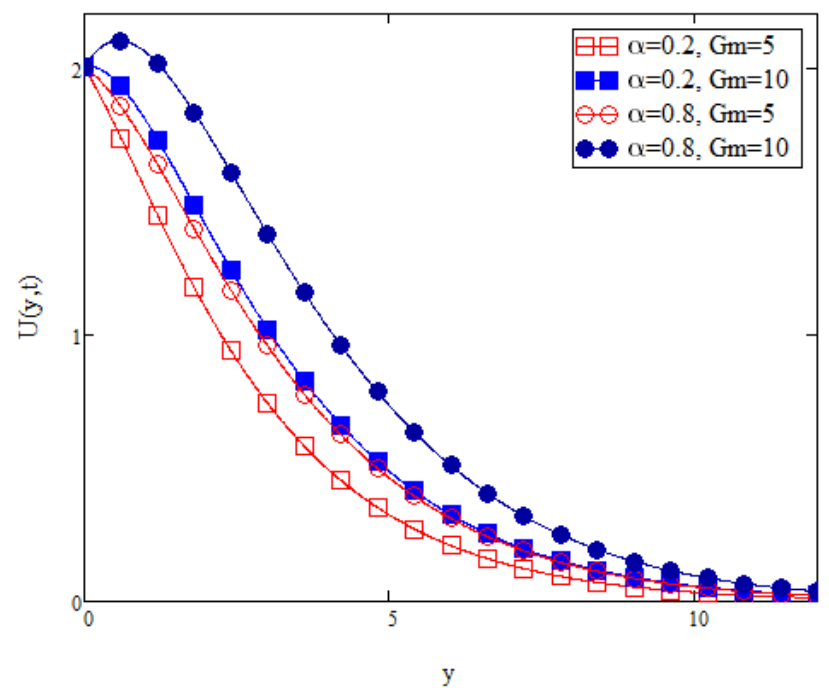
Figure 11. Variation in velocity profile due to variations in Gm and α